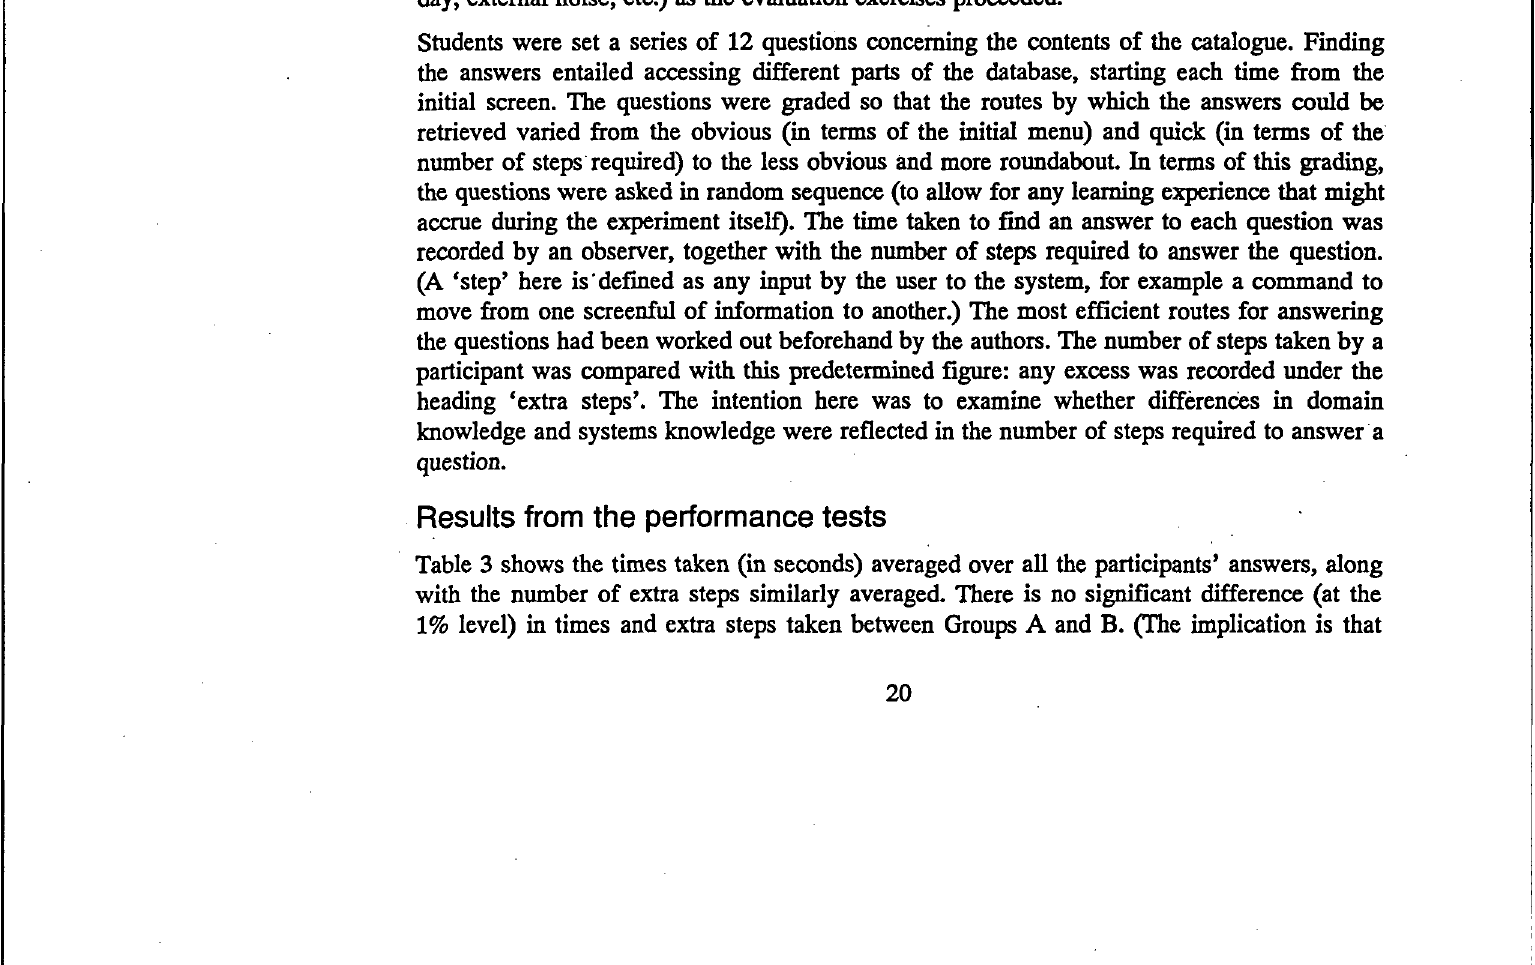
Table 2: Participants' prior acquaintance with HyperCard and dBase 7ZT+ The participants consisted of a mix of 20 overseas students and 20 UK-based students, evenly divided (10 overseas and 10 home-based students) in each group. This division formed an important part of the experiment, since the overseas students differed systematically in terms of background from home-based students. In general, overseas students were more experienced in terms of the use of catalogues (i.e. their acquaintance with the domain under test was better), but they had had appreciably less experience with computers (i.e. their system knowledge was less extensive). The interesting question, therefore, is whether overseas students have differing training needs from other